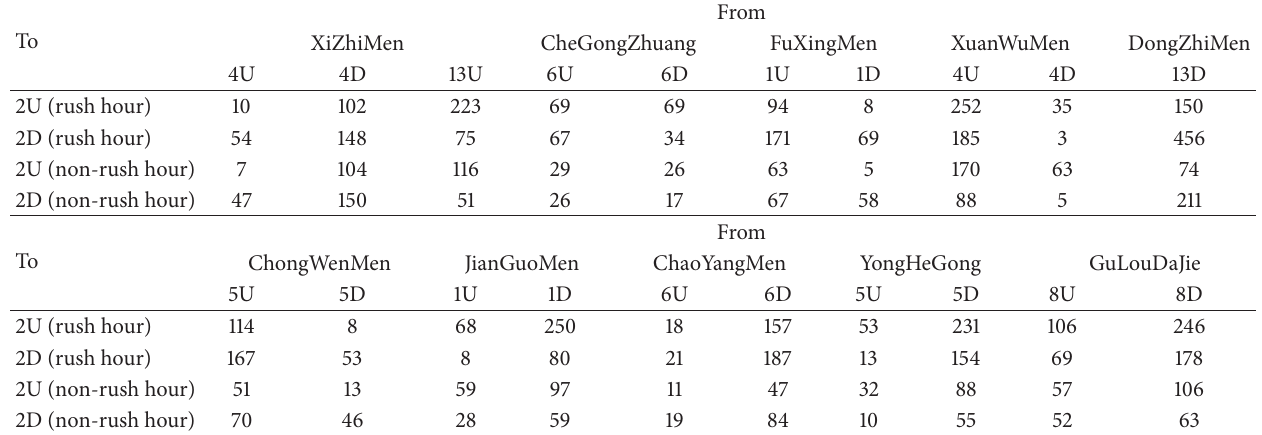
Table 6: The number of transfer passengers from one feeder train on feeder